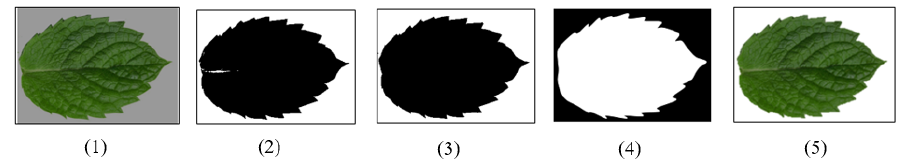
Figure 1. Image pre-processing steps to remove the background from an original image (see text for 1–5